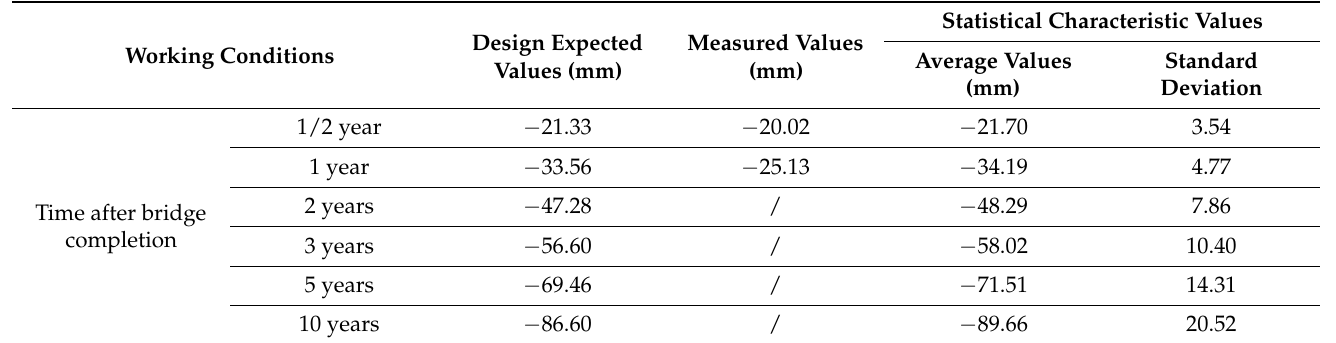
Table 5. Random analysis results for deformation at the mid-span of the main